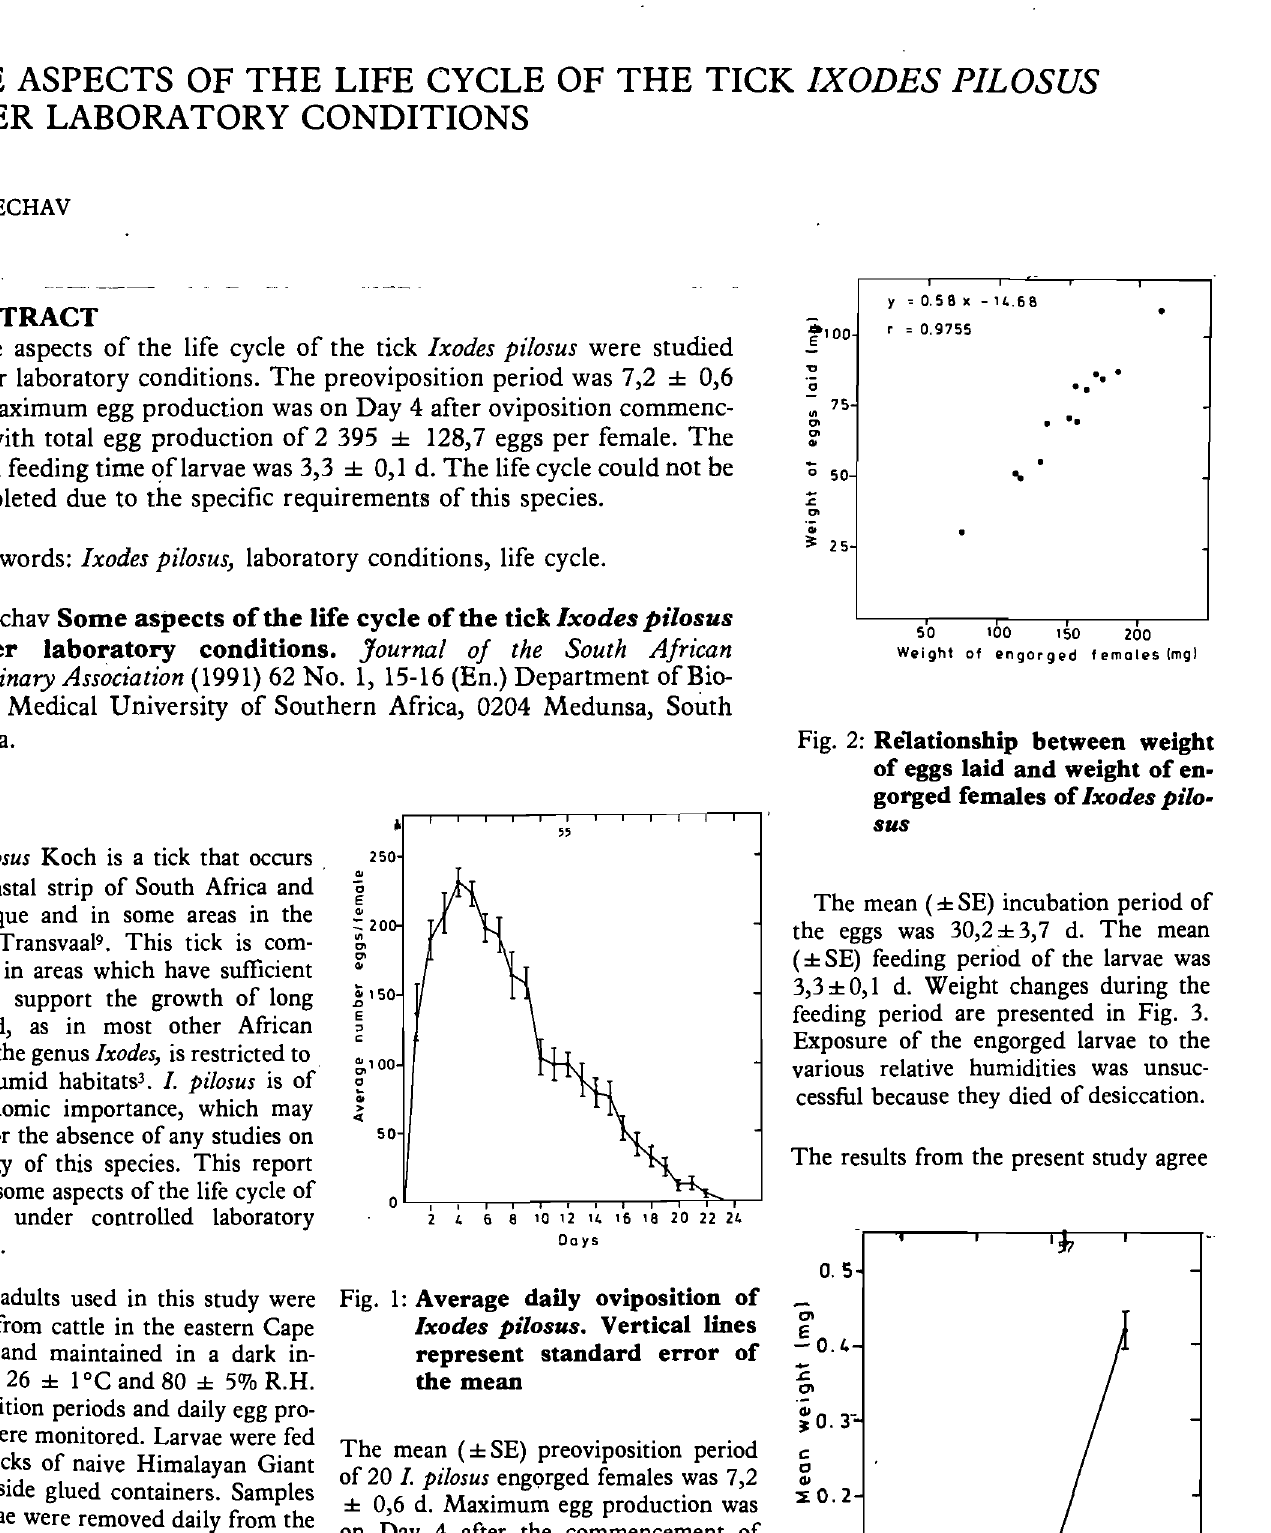
OL-,-,-,-r-r-r. -,. -.-.-.-P~~ I; 8 10 12 14 16 18 20 22 24 Oays Fig. 1: Average daily oviposition of Ixodes pilosus. Vertical lines represent standard error of the mean The mean (± SE) preoviposition period of 20 l. pilosus engQrged females was 7,2 ± 0,6 d. Maximum egg production was on Day 4 after the commencement of oviposition, with most of the eggs being laid during the fir!!t week (Fig. 1). The mean ( ± SE) daily production was 232 ± 10,3 eggs per female (range 136-314' eggs). The mean (± SE) total egg produc- tion (based on 20 females) was 2 345 ± 128,7 eggs per female (range 989 - 2 978). Fig. 3: The changes in weight of lar found between the weight of eggs and the vae of ixodes pilosus during weight of engorged females (Fig. 2). feeding